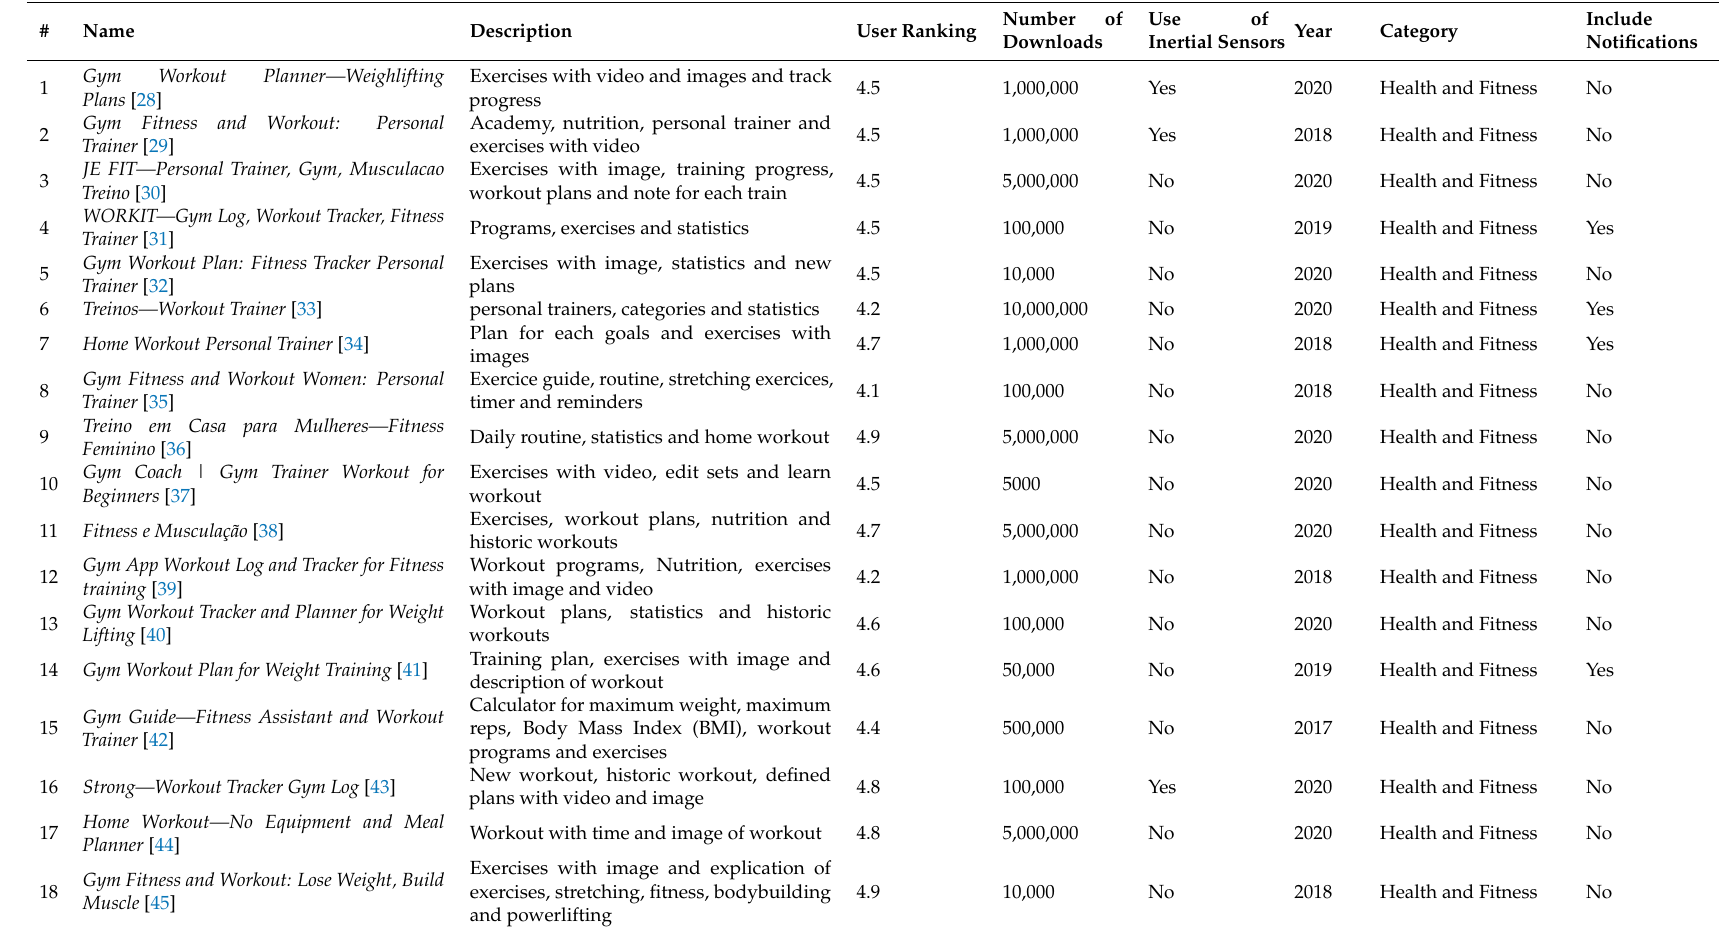
Table 1. Extraction of study